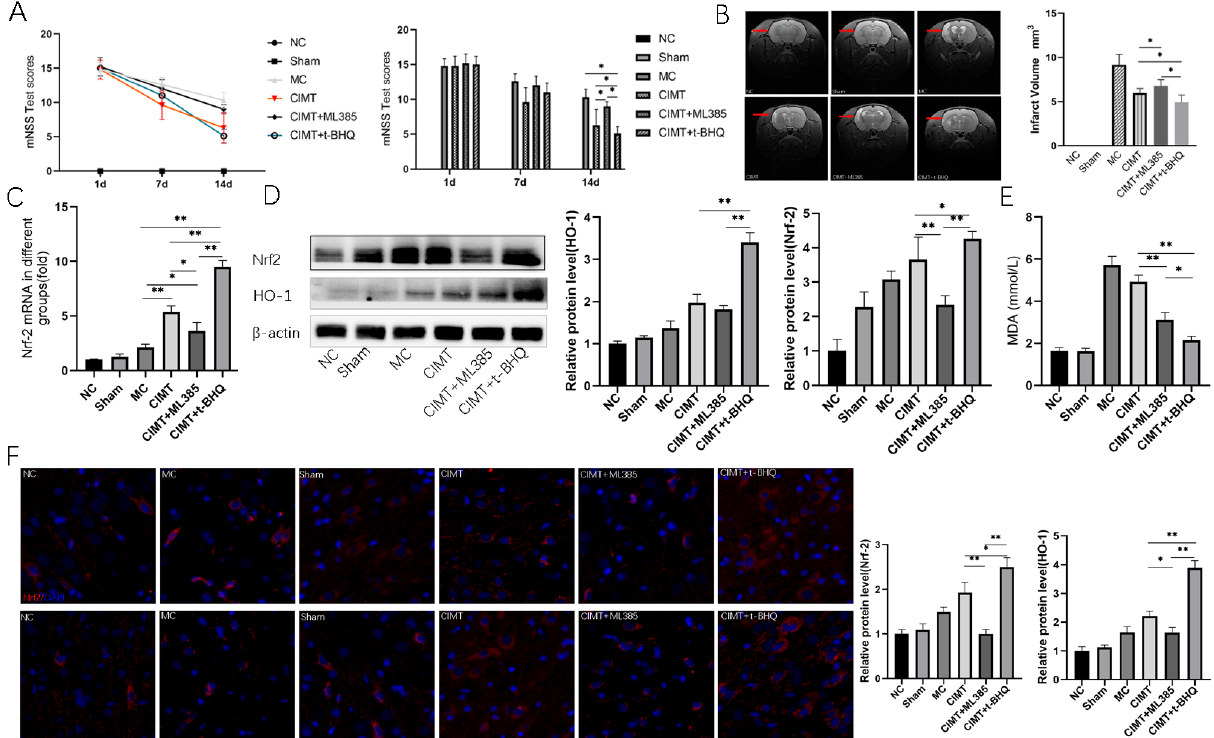
Figure 5. Nrf2 has a pivotal role in regulating CIMT induced benefits. ( A ) the mNSS test of rats in each group on days 1, 7, and 14; ( B ) coronal images of brain MRI performed after the intervention. The infarction regions were indicated by red arrows in the MRI, and the infarction volume of each group was calculated; ( C ) the relative expression of Nrf-2 mRNA detected by qRT-PCR; ( D ) the relative expression of Nrf-2 and HO-1 proteins detected by Western blot analysis. Representative images are shown. ( E ) the concentration of MDA in the peri-infarct zone of the brain; ( F ) the relative expression of Nrf-2 and HO-1 detected by immunofluorescence. Representative images are shown. NC: normal control; MC: model control; CIMT: constraint-induced movement therapy; UE: unconstraint exercise. *: p < 0.05; **: p < 0.01.